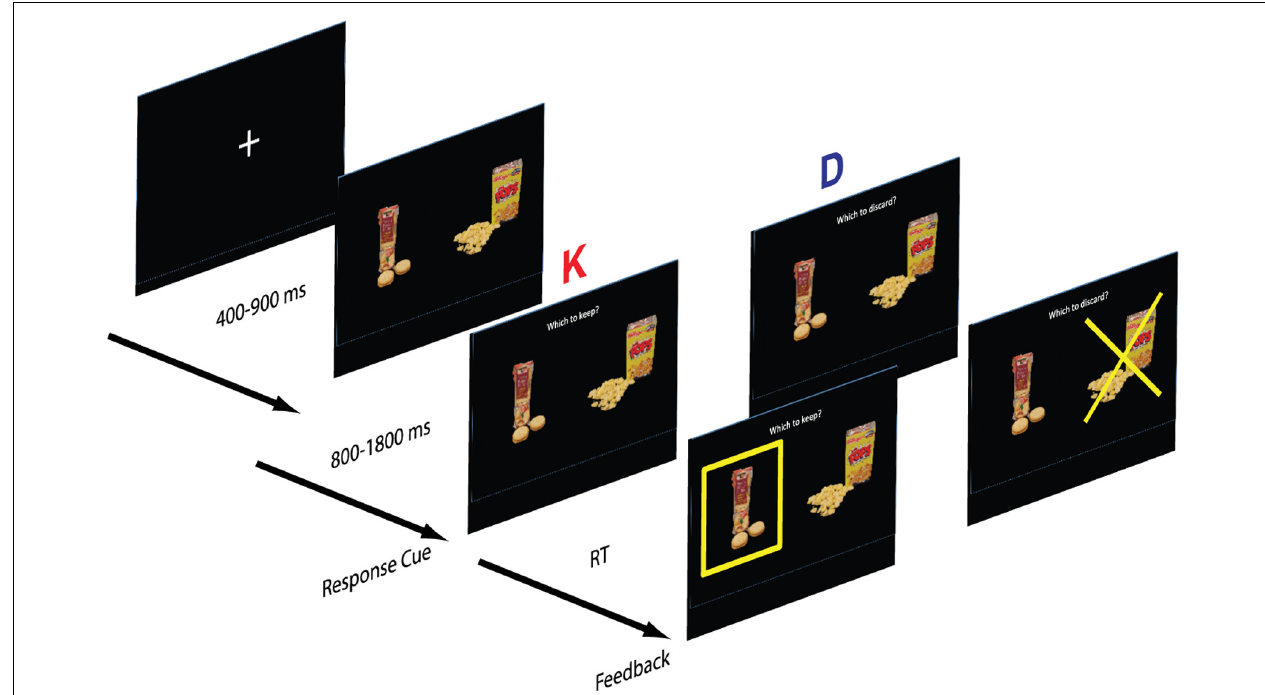
(D), subjects discarded the less preferred item.The small food images are modified from the stimulus set developed by Ian Krajbich and Antonio Rangel and shared with